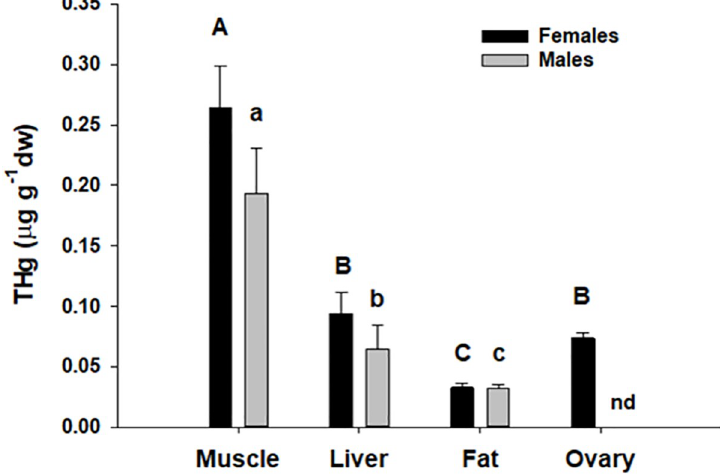
Fig 4. Comparison of THg concentrations in lionfish tissues by sex. Total mercury concentrations in lionfish tissues in female (solid black bars) and male (solid grey bars) lionfish. Male testes were not sampled (nd). No significant differences were observed for tissues as a function of sex; letters (capitals = females; lower case = males) above tissues represent significant differences from total mercury in tissue types from a Ryan’s Q post-hoc test (see text for details) following